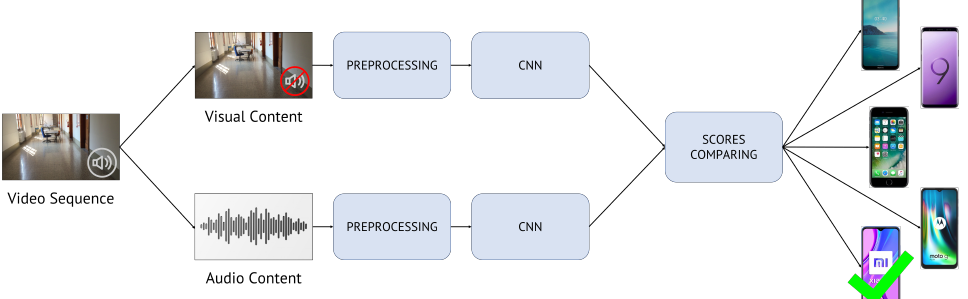
Figure 5. Late Fusion method pipeline. Given a query video, we extract and pre-process its visual and audio content. Then, we separately feed two distinct CNNs: one only with visual information and the other one only with audio information. Eventually, we compare and fuse the classification scores to identify the actual source camera model.